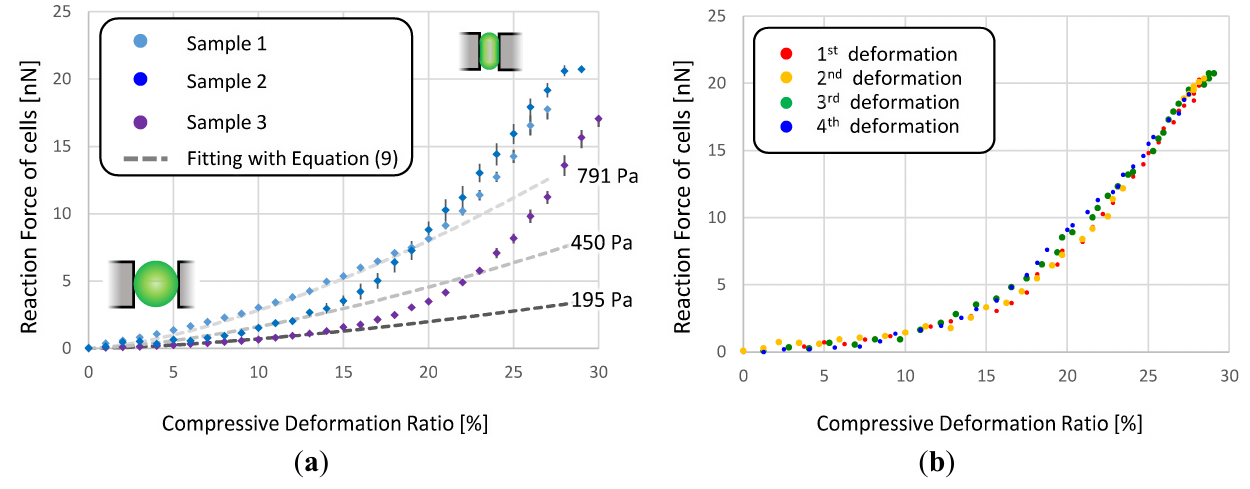
Figure 8. Experimentally obtained mechanical characteristics of MDCK cells: ( a ) The difference when repetitive deformation is applied and ( b ) the characteristics of three samples at first